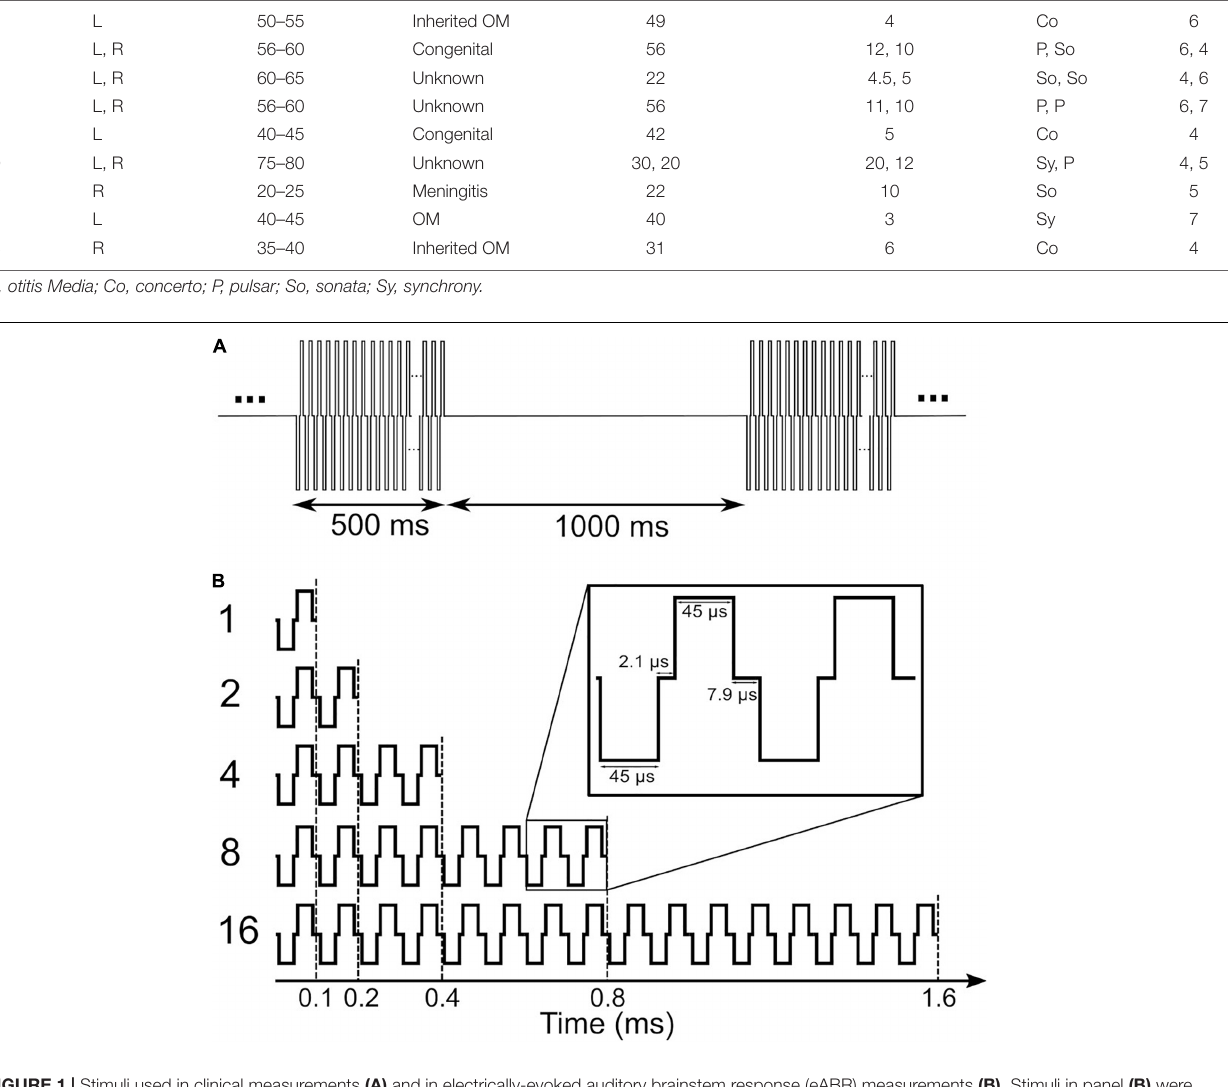
FIGURE 1 | Stimuli used in clinical measurements (A) and in electrically-evoked auditory brainstem response (eABR) measurements (B) . Stimuli in panel (B) were presented at a repetition rate of 37